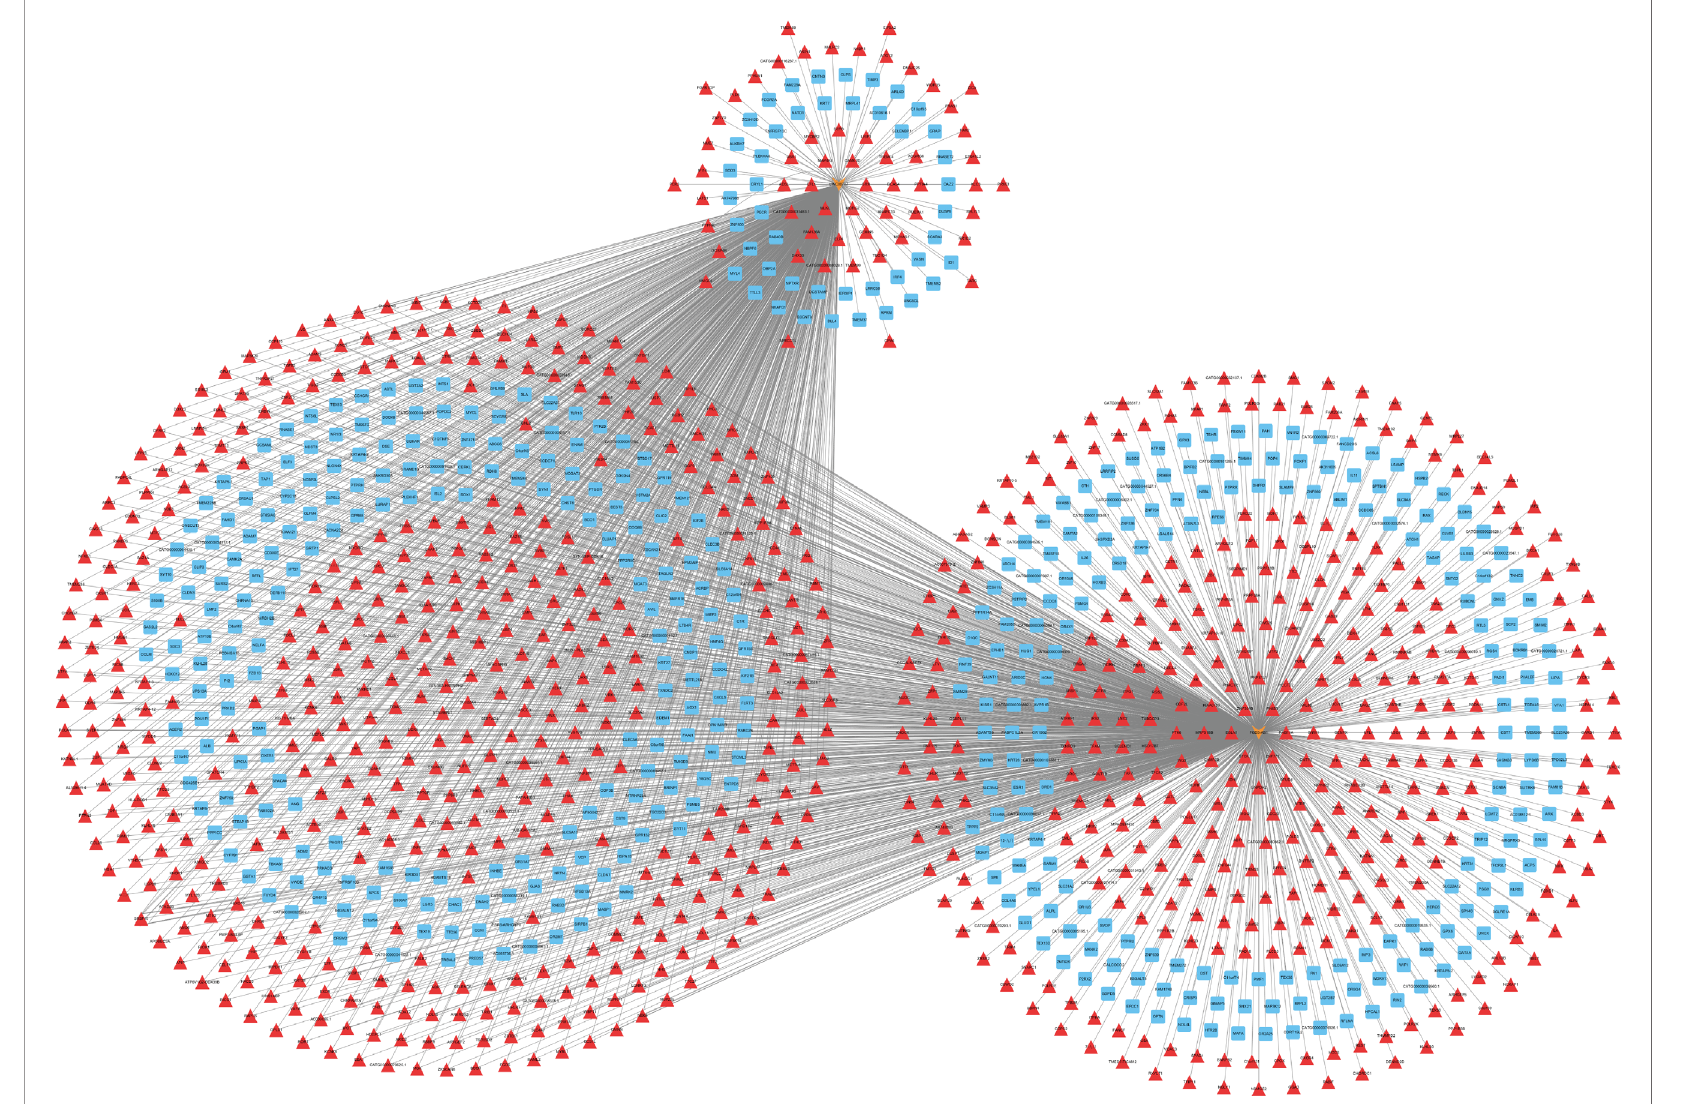
FIGURE 6 | LncRNA-mRNA co-expression network in Ct-infected HeLa cells at 12 and 24 post-infected hours. The network was based on the Pearson relation coef fi cient of a lncRNA targeting an mRNA. Light orange shapes correspond to lncRNAs. Squares and triangle correspond to mRNAs. Red means upregulation, and blue means